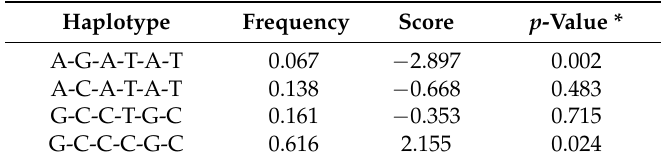
Table 3. Estimation of haplotype frequencies in the IPMK SNPs (in order: rs2790156,